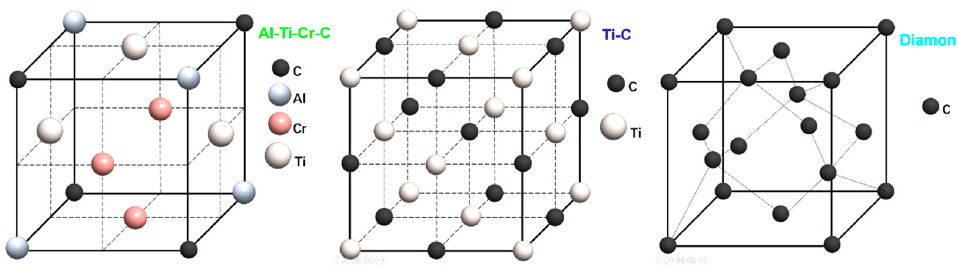
Coatings 2022 , 12 , x FOR PEER REVIEW Figure 1. Crystal Structure Models of AlTiCrC, TiC, and Diamond. Figure 1. Crystal Structure Models of AlTiCrC, TiC, and Diamond.